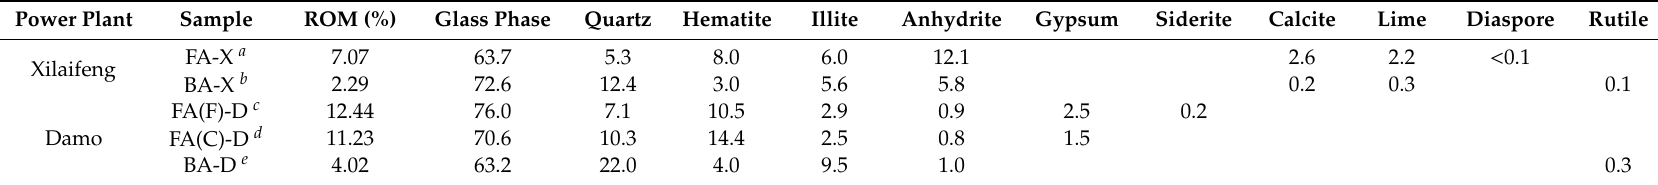
Table 4. Average values of mineralogical compositions of coal combustion products (CCPs) from the Xilaifeng and Damo power plants (%). Power Plant